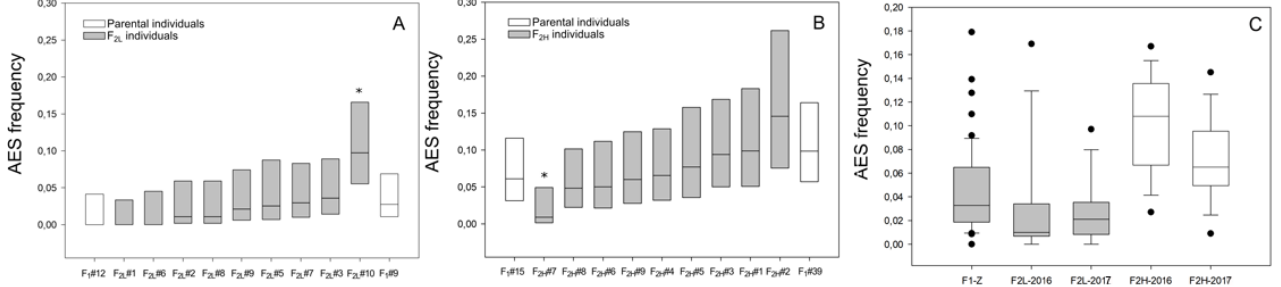
Figure 4. Frequency of apospory expressivity of the two F 2 offspring measured during 2017 ( A ) F 2L and ( B ) F 2H . The parental genotypes are in white boxes and hybrids in grey boxes. Asterisks indicate a significant difference ( p < 0.05) of the progeny compared to the parental genotypes ( p < 0.05). The frequency of ovaries containing AES (box middle line) scored in each plant is plotted together with 95% confidence intervals (CI). ( C ) Apospory expressivity variation of F 1-Z (2016), F 2L , and F 2H progenies (2016 and 2017). Boxes represent the 95% confidence intervals (CI), the middle lines indicate the median value, outliers are marked by black circles, and different colors indicate significant differences between median values ( p < 0.05).